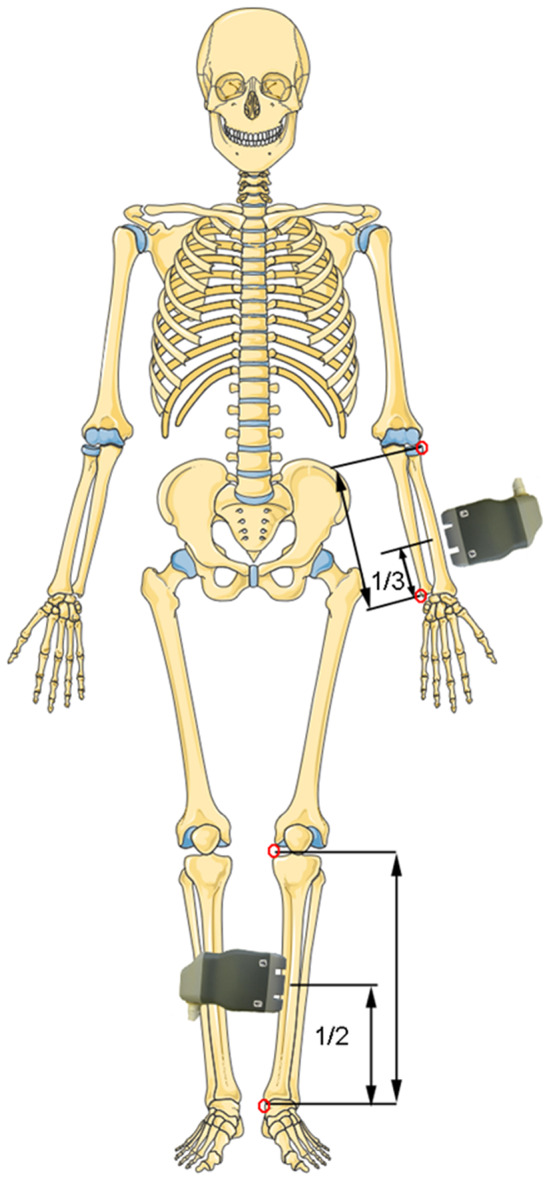
Ultrasound measurement locations. The landmarks used for the identification of the longitudinal positions are marked by red dots. (Adapted from Servier Medical Art by Servier under a Creative Commons Attribution 3.0 Unported License).